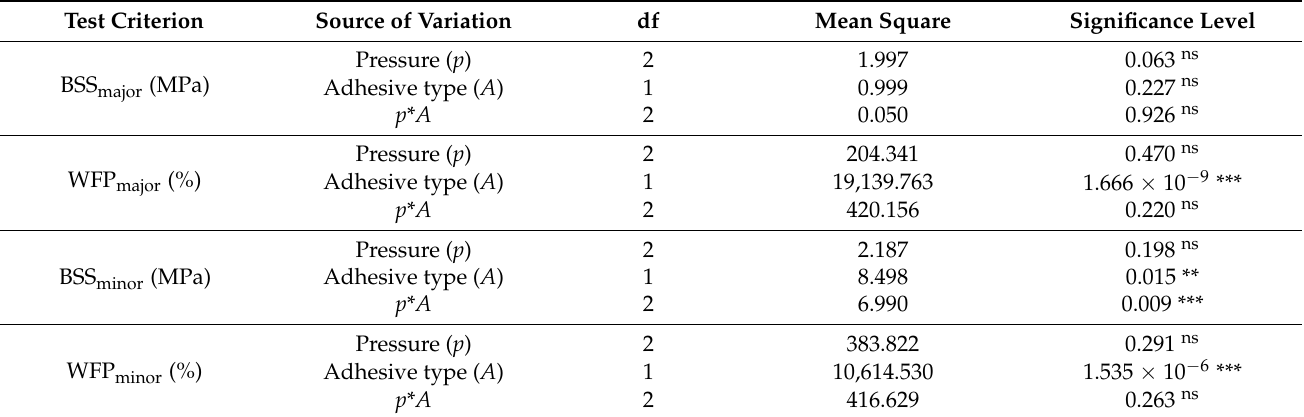
Table 4. Analysis of variance (ANOVA) for bonding shear characteristics of